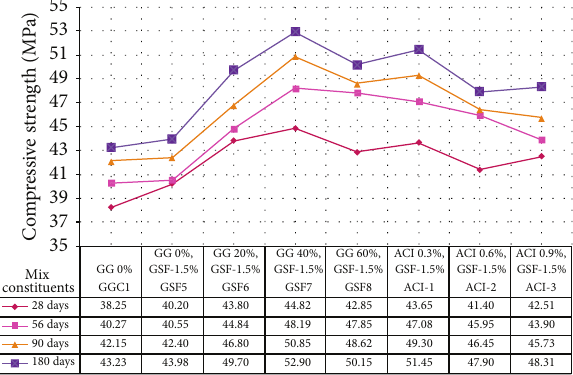
Figure 8: Compressive strength of concrete cured in NaCl (3%) solution for various concrete mixes (60% stressed).